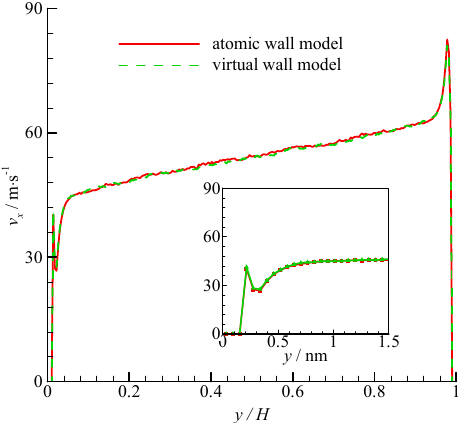
Figure 5. Velocity profiles of the atomic and virtual wall MD simulations across the channel in Couette flow. The non-dimensional wall distance (non-dimensionalized by the channel height H ) is used in large figure, and the dimensional wall distance is used in the zoomed-in figure.